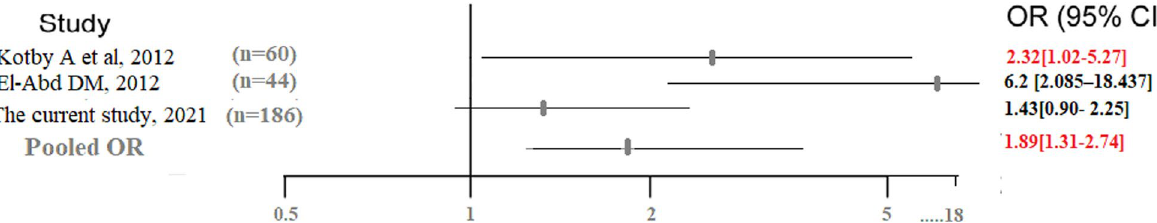
Fig. 2 The ORs with its 95% CIs for the MTHFR C667T in children for congenital heart defects according to allele frequency T versus C. Random‑effects pooled OR